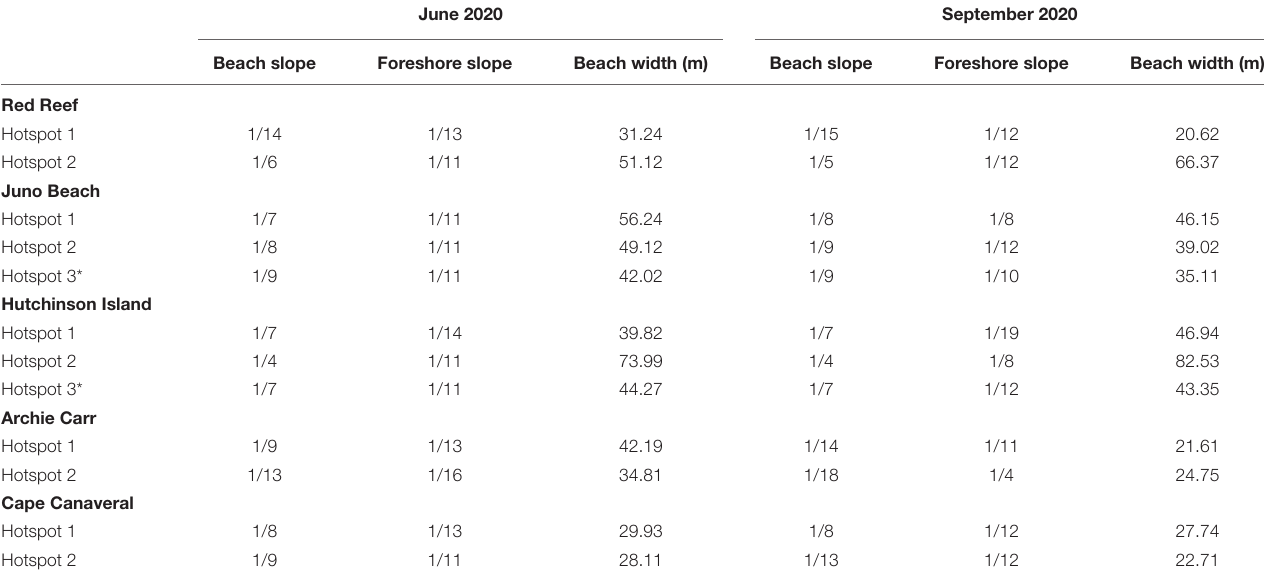
TABLE 4 | Beach morphology characteristics at all five study sites during 2020 nesting